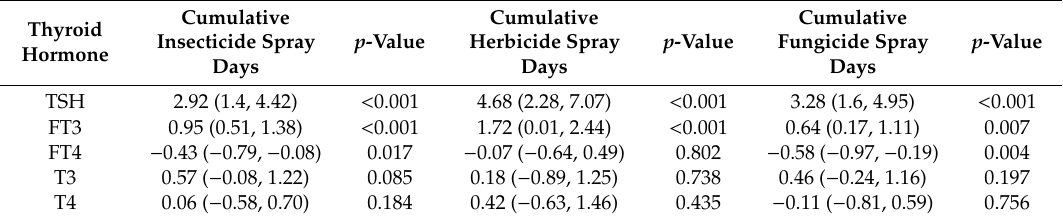
Table 5. Percent change (95% CIs) of thyroid hormones per 10 days of self-reported cumulative pesticide spray days from a linear mixed model * with a random intercept for subjects and days of pesticides sprayed and covariates including BMI, gender, and baseline